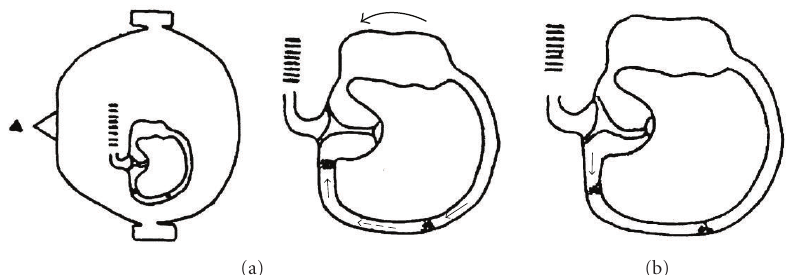
Figure 3: (a) When the patient in supine position rolls his/her head by 180 ◦ from the right side to the left side (outer arrow), the endolymphatic flow (dashed arrow) pushes the debris localized in the anterior arm of the canal towards the cupula and those in the posterior arm towards the lowermost part of the canal (thin arrows). (b) Therefore, when the head is still in this position, the debris in the anterior arm of the canal moves away from the ampulla due to gravity (thin arrow), provoking an ampullofugal flow and a right beating apogeotropic nystagmus (head arrow), while the debris in the posterior arm does not provoke any